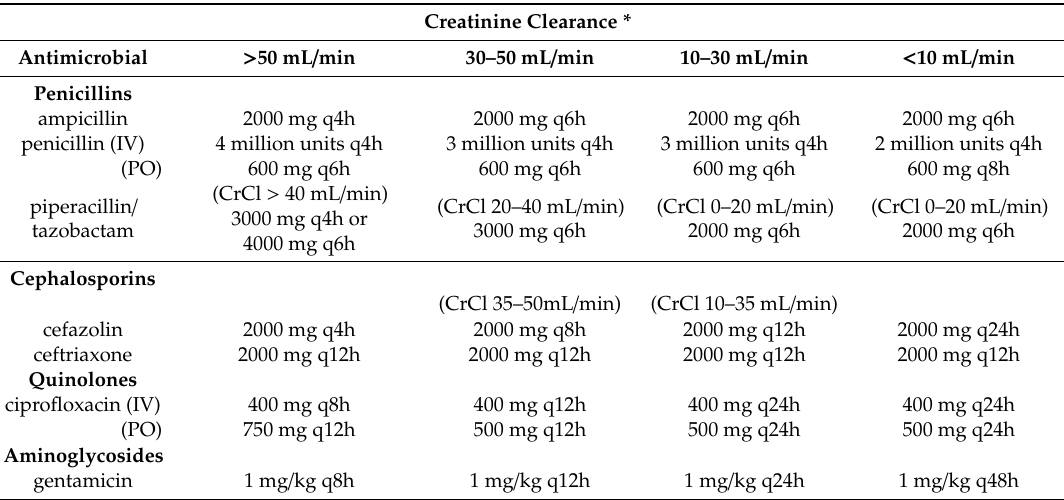
Table 1. Dosing regimens for the most frequently prescribed